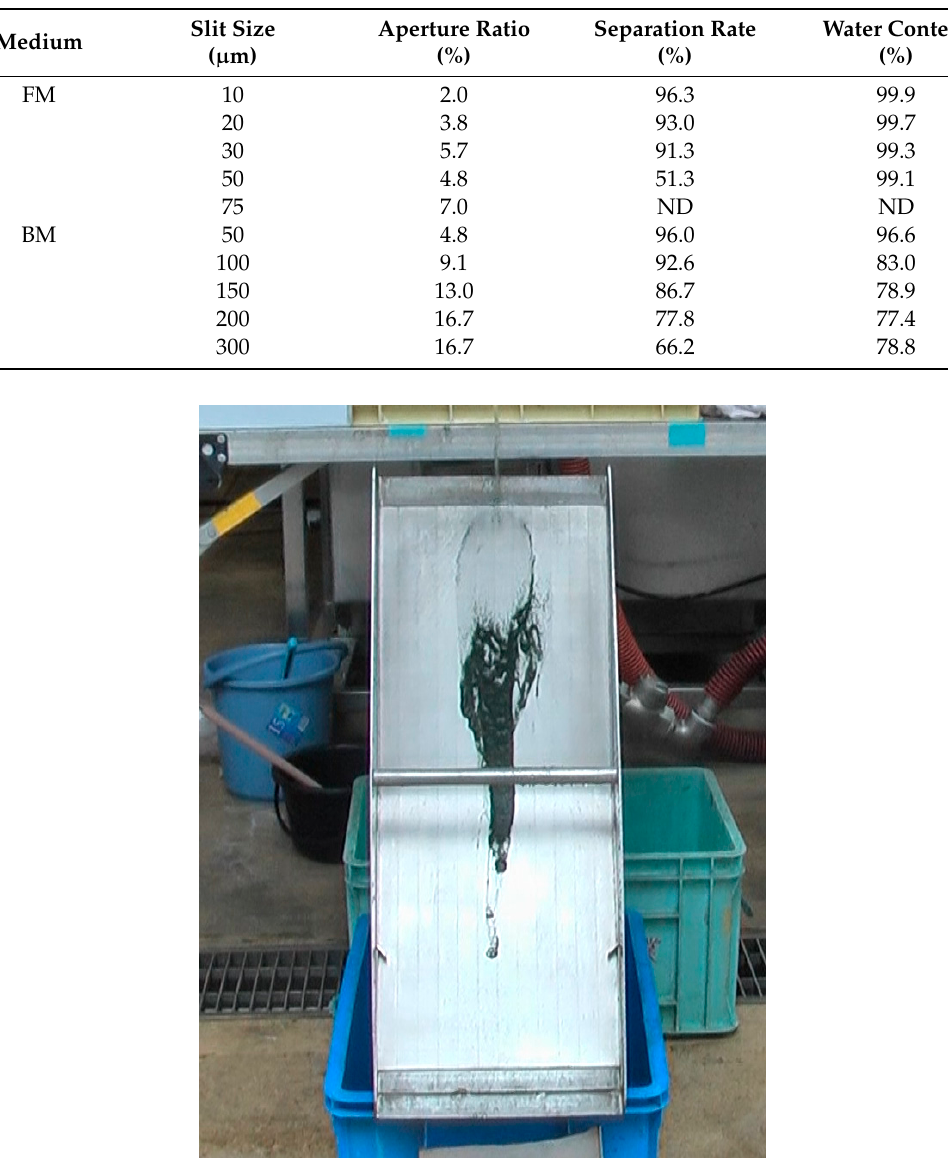
Table 2. E ff ect of the slit size of the wedge-wire screen on the separation rate and water content of the algal slurries recovered from di ff erent media. FM: Freshwater medium, BM: Brackish medium. At a slit size of 75 µ m, almost all the algae cultured in the FM passed through the screen, and hence the water content and the separation ratio could not be determined (ND).